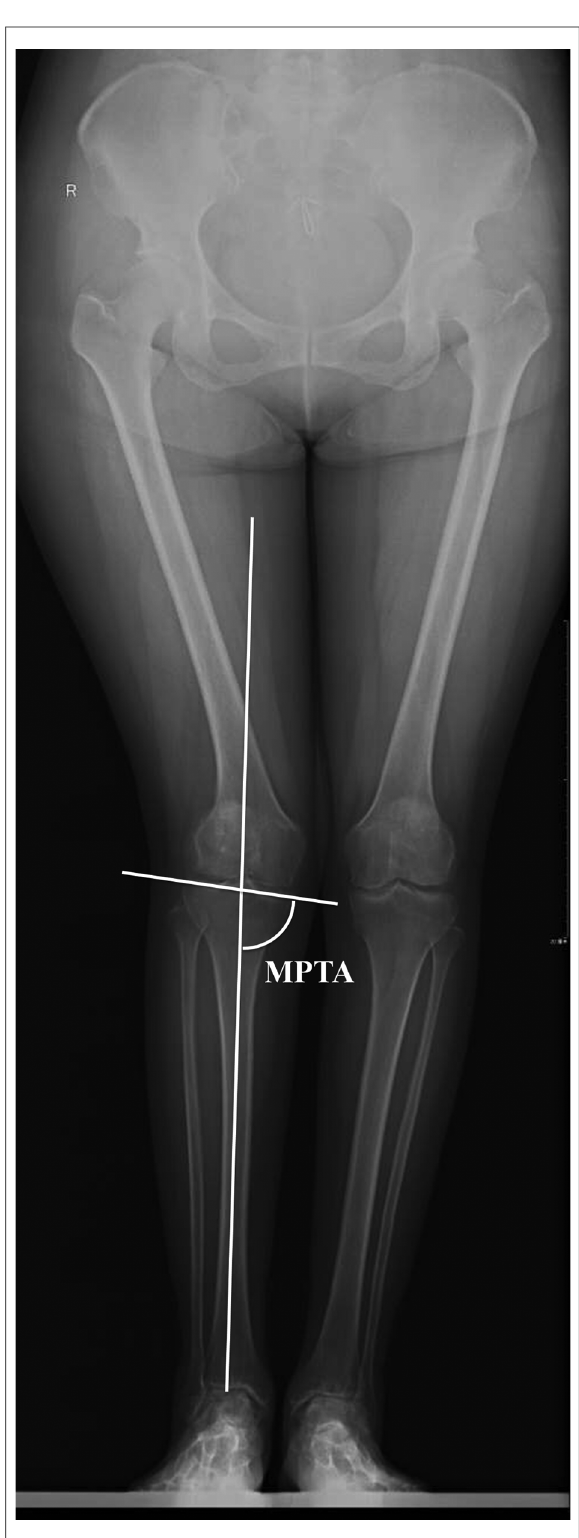
FIGURE 1 On anteroposterior view of the full-length x-rays, the medial proximal tibial angle (MPTA) was measured as the medial angle between a line connecting the medial plateau and lateral plateau and a line connecting the center of the tibial eminence and the center of the talar